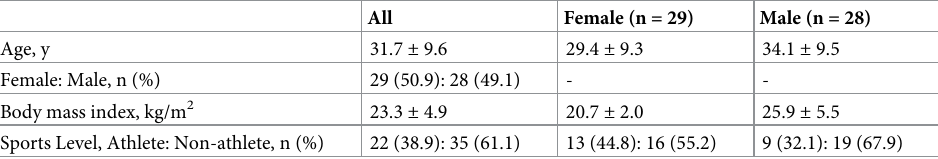
Table 1. Demographic data (N = 57).